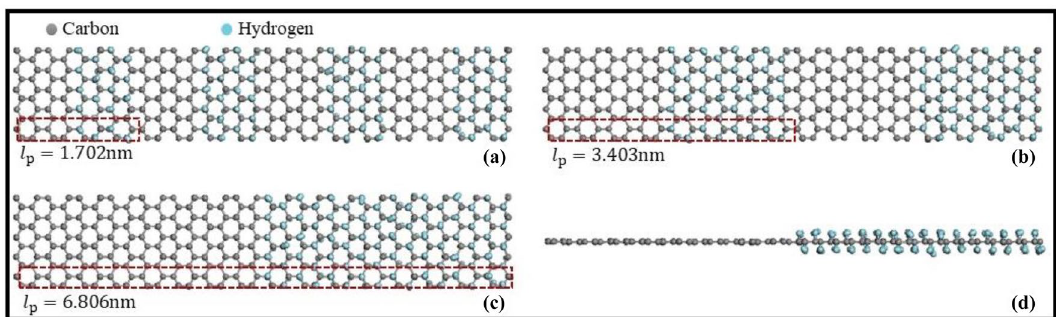
Figure 1. A unit cell of graphene/graphane superlattice nanoribbons having various superlattice periods ( a ) l p = 1.702 nm, ( b ) l p = 3.403 nm, and ( c ) l p = 6.806 nm. ( d ) front view of the unit cell depicted in ( c